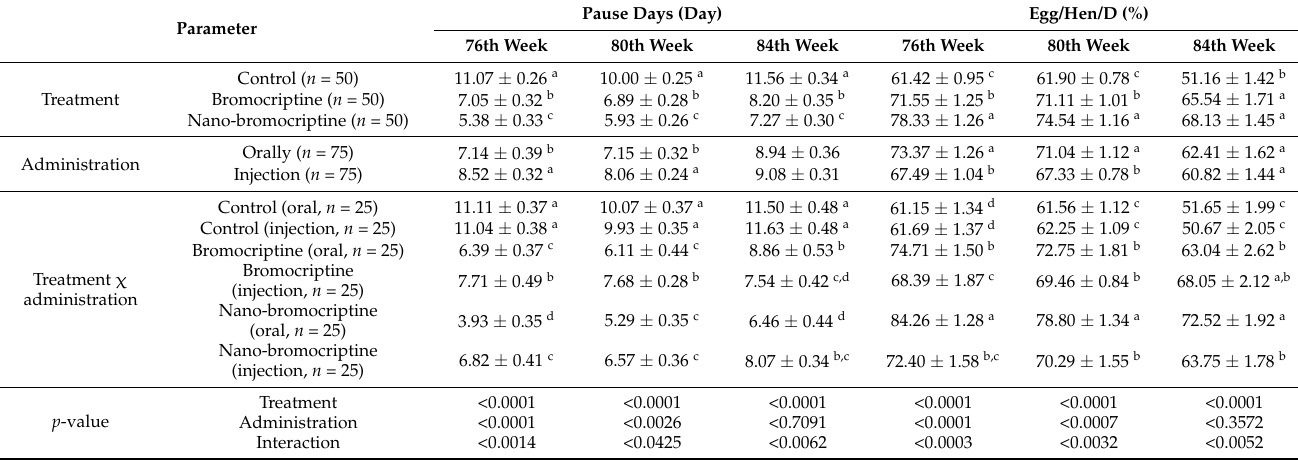
Table 1. Effects of bromocriptine and nano-bromocriptine on pause days and egg production percent of late laying hens.